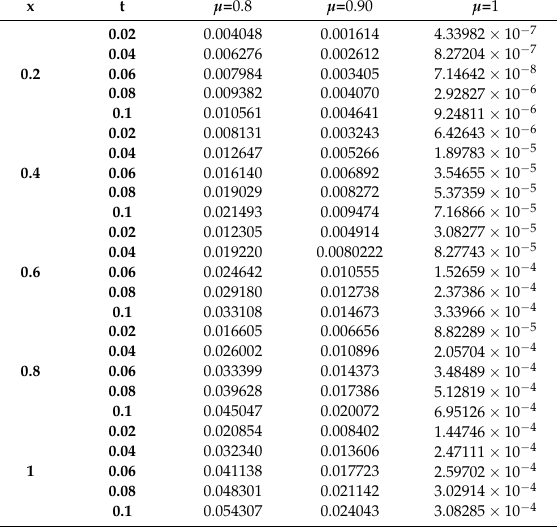
(cid:12) (cid:12) (cid:12) (cid:12) − v ) considered in case ( i ) using q -HATM at ρ = − 0.5, ε = q − HATM (cid:12) v Exact (cid:12)